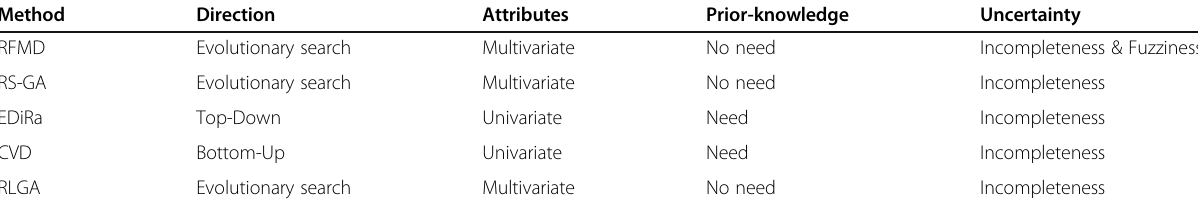
Table 11 Key differences among the mentioned discretization methods Method